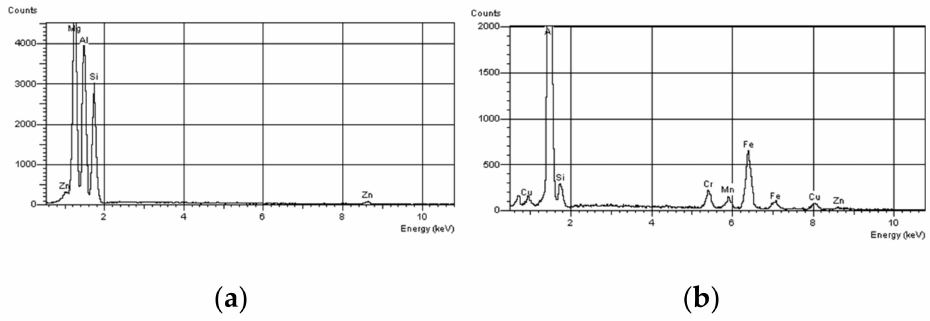
Figure 4. Characteristic X-ray spectra obtained from the phases shown in Figure 3: ( a ) Mg 2 Si phase,